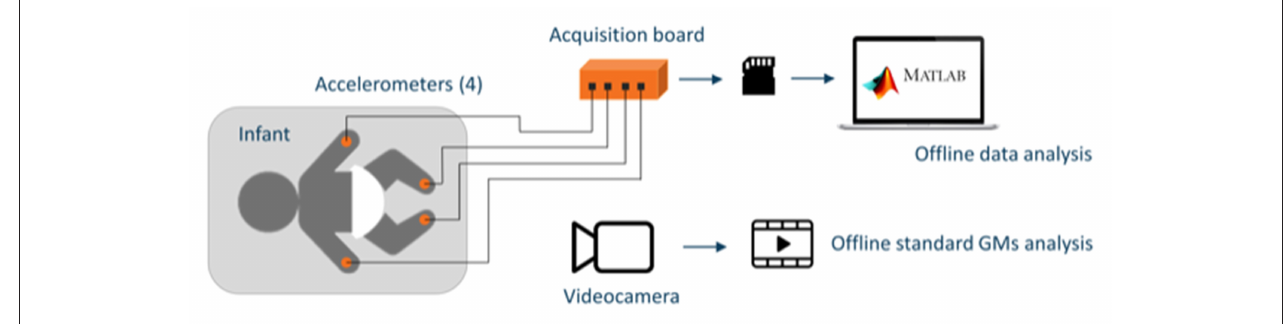
FIGURE 1 | Schematic representation of the setup including the four accelerometers placed on the wrists and ankles of the infants and connected to the acquisition board that stores data on an SD memory card for offline analysis and the video recording device used for offline general movement assessment (GMA).